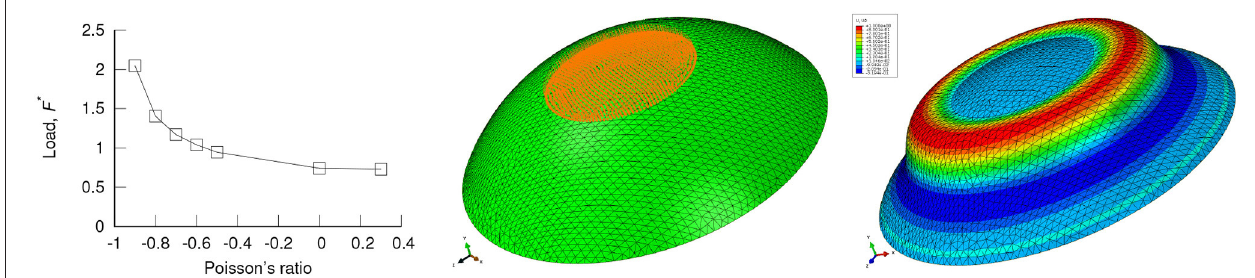
FIGURE 3 | Eigenvalue analysis for “boss” loading of a solid dome, showing: (Left) the buckling load, (middle) the prescribed displacement of the “boss” area and (Right) the 1st buckling mode.